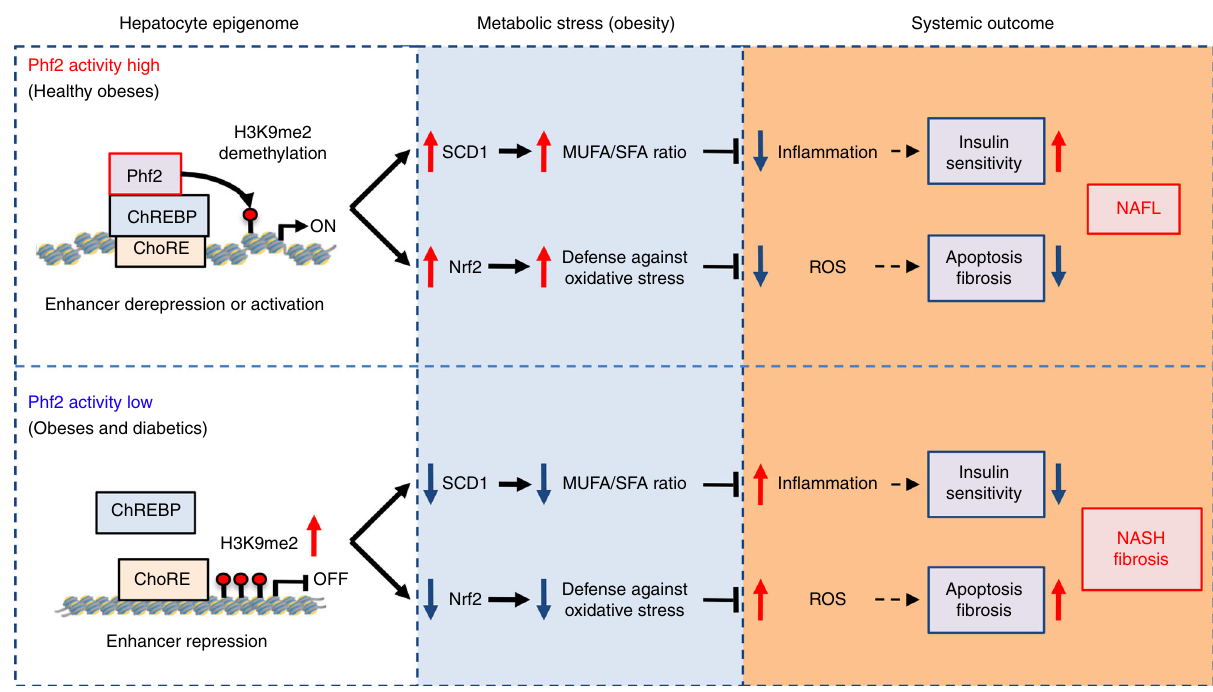
Fig. 10 Schematic representation of Phf2 action in NAFL development and progression. Phf2 activation, through H3K9me2 demethylation at speci fi c ChREBP-regulated gene promoter, increases MUFA synthesis and anti-oxidative stress defenses. Consequently, Phf2 activation protects liver from in fl ammation, insulin resistance, oxidative stress, and fi